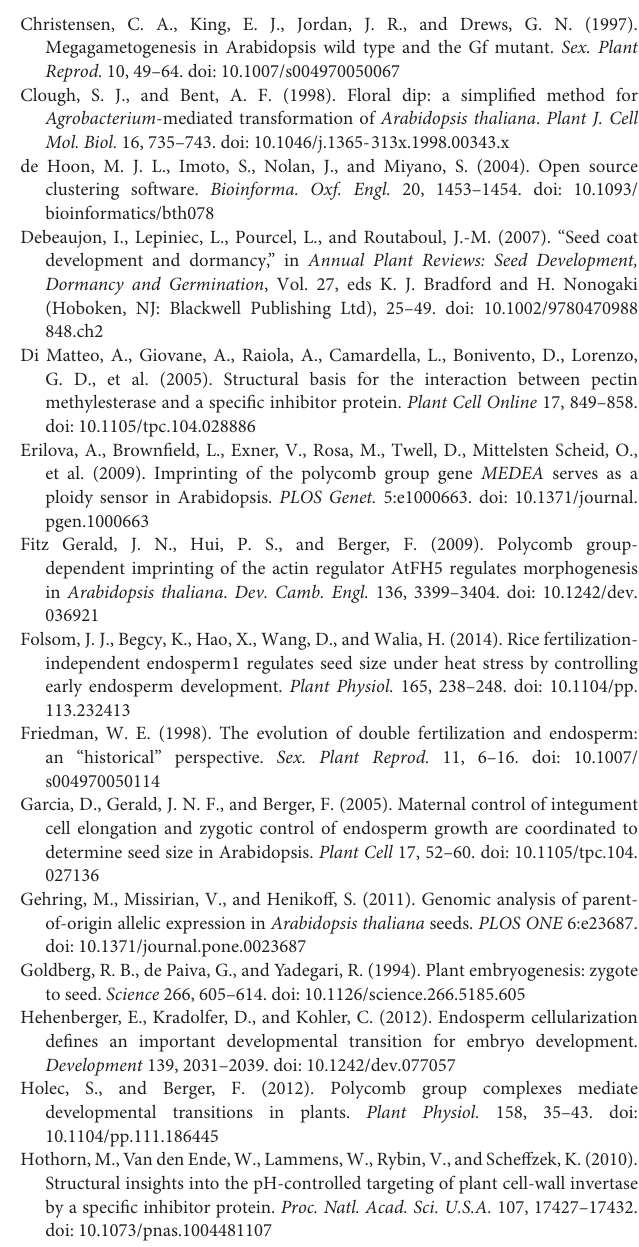
FIGURE S1 | In silico expression analysis of InvINH1 and InvINH2 . (A) The relative expression level was illustrated as a heatmap containing 87 anatomical features that were hierarchically organized by the Anatomy tool from Genevestigator. (B) The Perturbations tool from Genevestigator was used to generate the heatmap displaying the experimental stimuli that induced greater than 1.5-fold changes in the expression level of InvINH1 and InvINH2 . InvINH1 and InvINH2 are represented by the same Affymetrix probe,